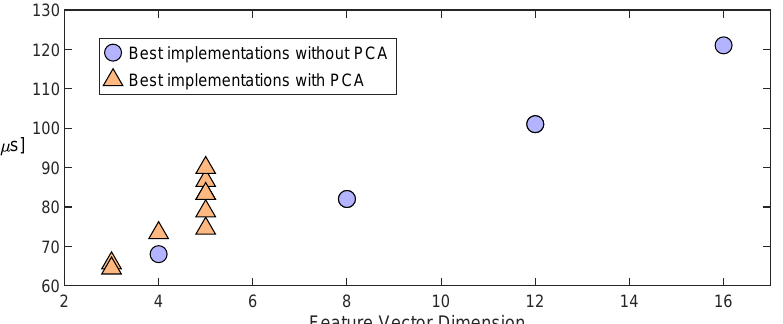
Figure 15. Feature extraction delay plus classification delay vs. the classifier input feature vector dimension. The results correspond to the cases in Tables 4 and 6, for the implementations without PCA and with PCA,